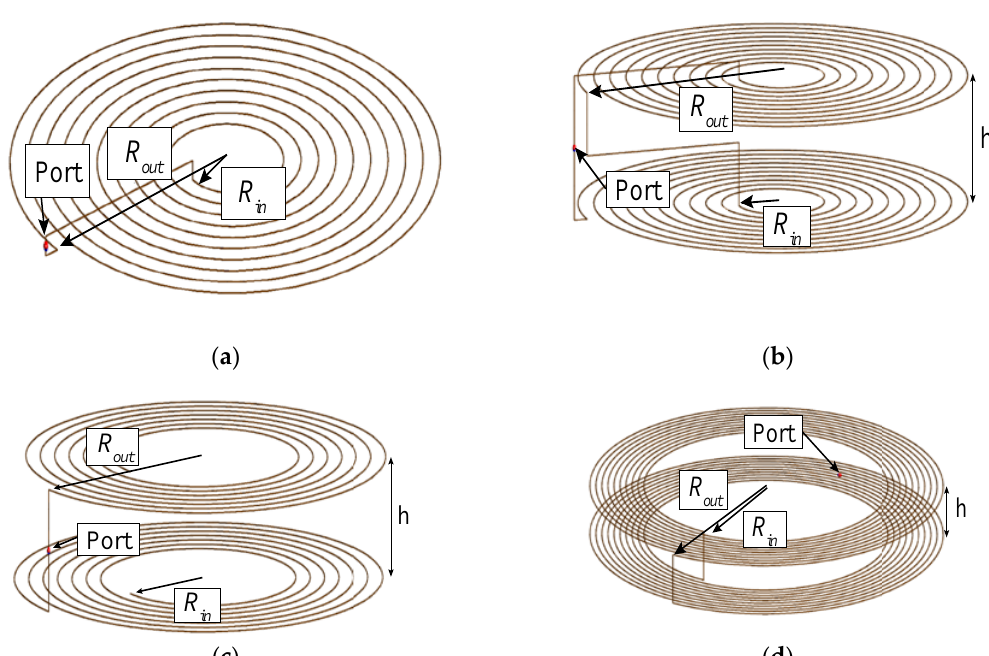
Figure 10. Single models: ( a ) short-type single-layered spiral, ( b ) short-type double-layered spiral, ( c ) Open-type double-layered self-resonant spiral, and ( d ) folded spiral resonator with double-layered structure.